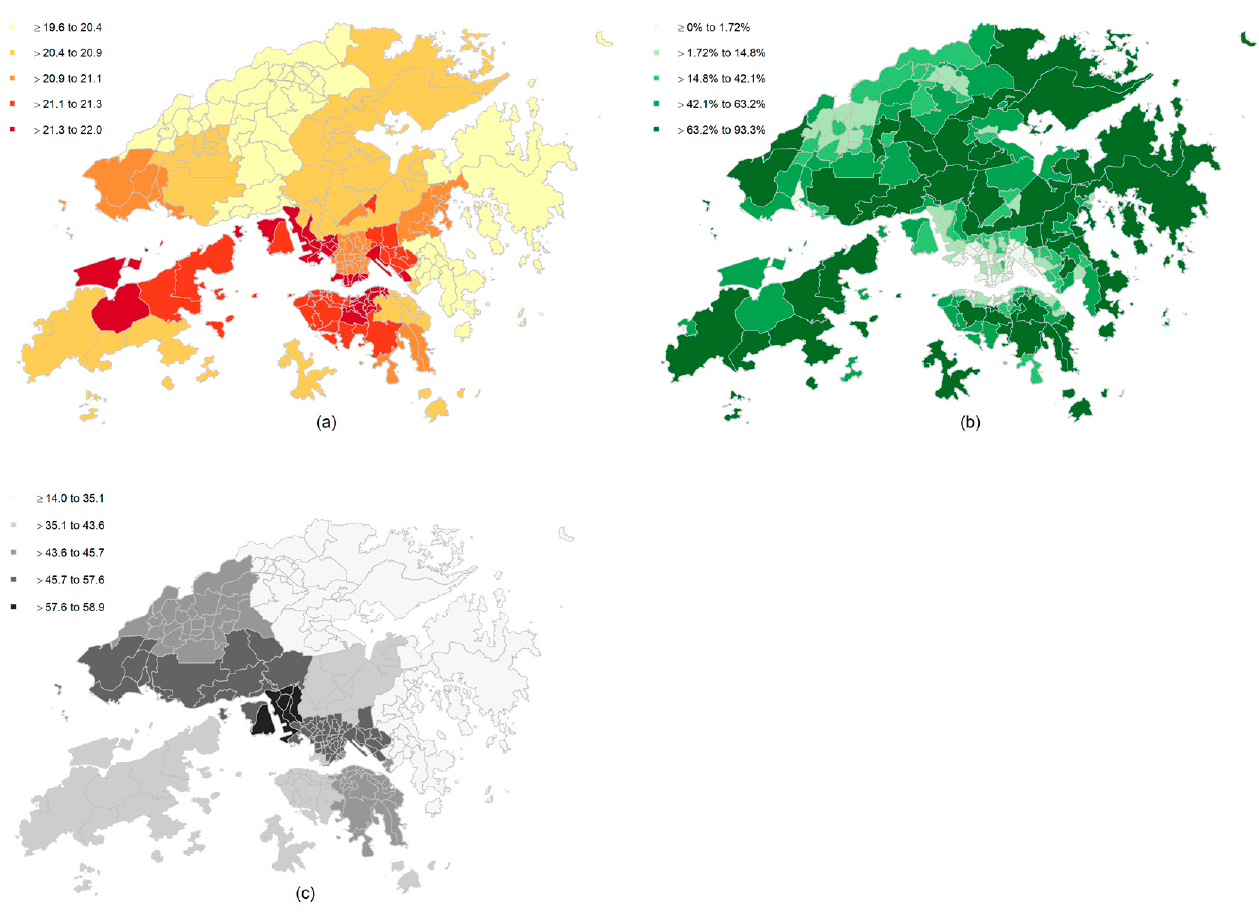
Figure 3. Non-accidental mortality and crude relative risk of mortality in Hong Kong in 2016. Note: a five-level scale is used to provide a balance between differentiation and clarity.